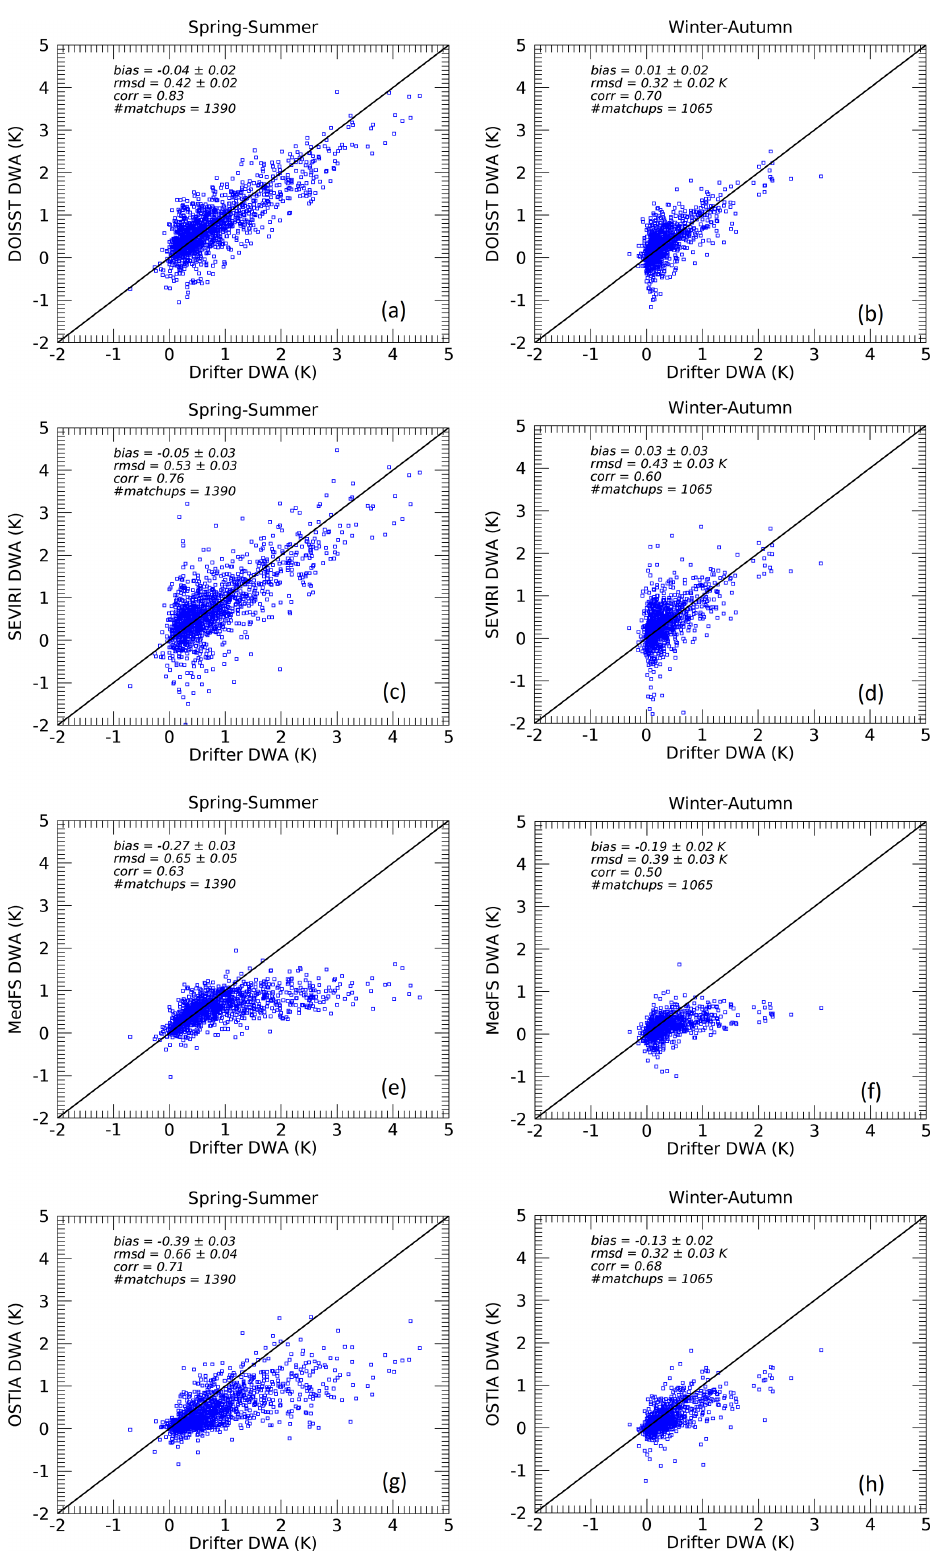
Figure 7. DWA scatterplots for DOISST (a, b) , SEVIRI L3C (c, d) , MedFS (e, f) , and OSTIA diurnal (g, h) vs. drifters during spring (MAM), summer (JJA), winter (DJF), and autumn (SON) over the period 2019–2020.